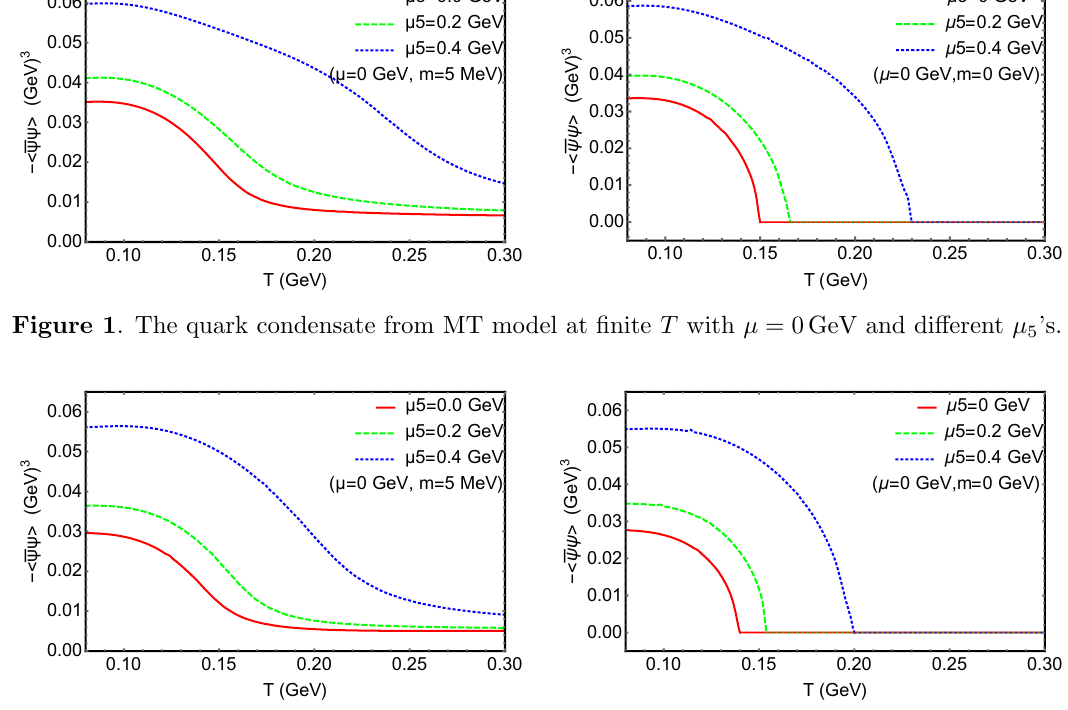
Figure 2 . The quark condensate from QC model at (cid:12)nite T with (cid:22) = 0 GeV and di(cid:11)erent (cid:22) 5 ’s. The indicates the free quark (cid:12)eld. Meanwhile, a rigorous de(cid:12)nition exists as h (cid:22) i being 0 the (cid:12)rst derivative of partition function versus current quark mass m ,